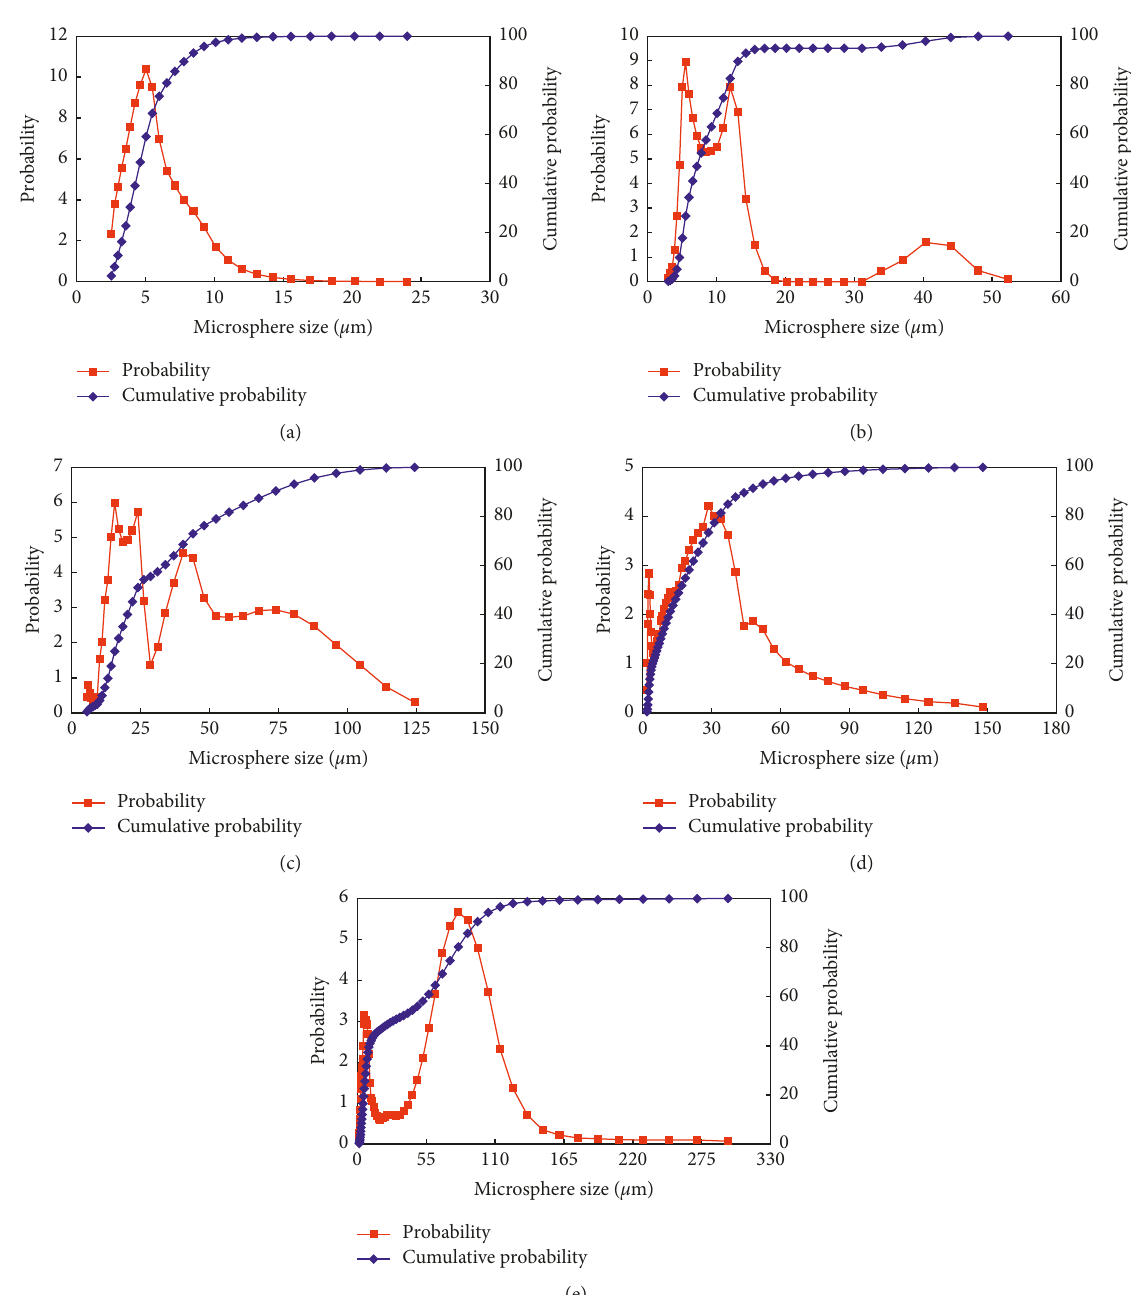
Figure 3: Polymeric microsphere size distribution at different periods of hydration: (a) 0 days, (b) 3 days, (c) 7 days, (d) 14 days, and (e) 21